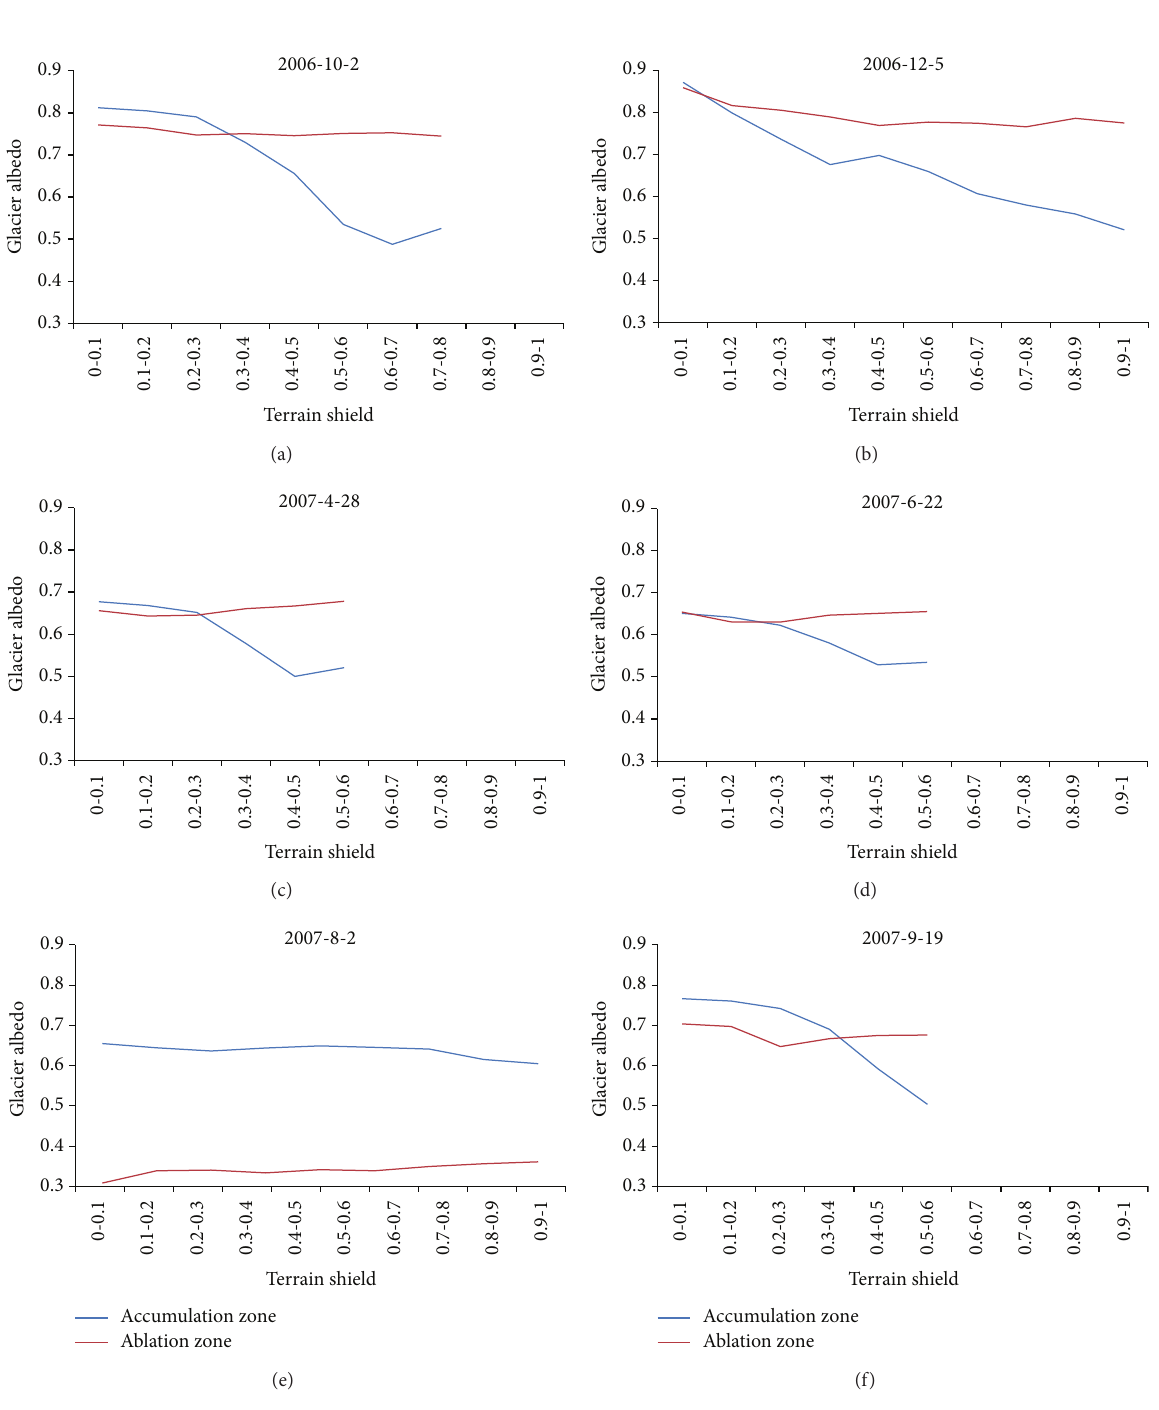
but there was no obvious relationship to air